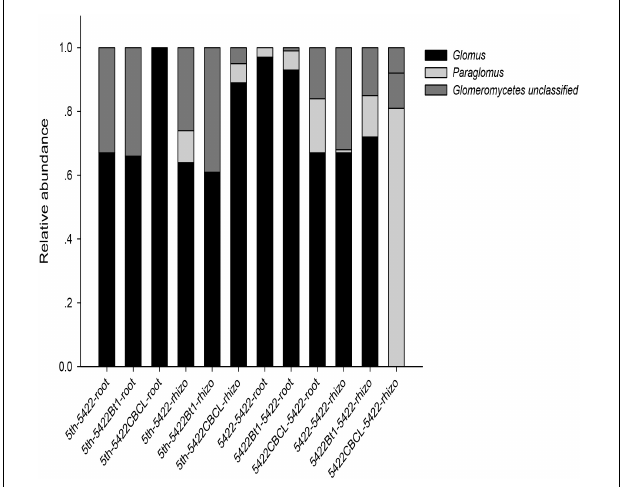
FIGURE 2 | Proportional distributions of genera in the AMF community among the samples. The horizontal axes of the first six samples are labeled according to the following formula: season of cultivation-maize variety -sample type. The horizontal axes of the last six samples are labeled according to the following formula: the straw added to the subsequent maize variety–subsequent season maize variety-sample type. the fifth season or subsequent straw of maize varieties including 5422Bt1, 5422CBCL and 5422; maize types including 5422Bt1, 5422CBCL and 5422; sample types including roots and rhizosphere soils. Rhizo, rhizosphere soils.